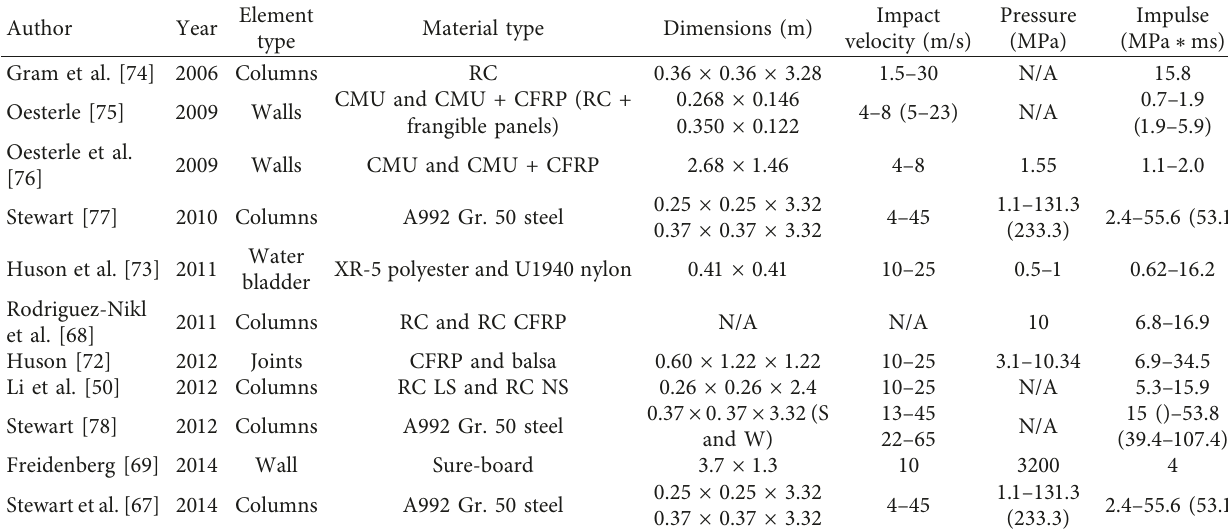
Table 4: Blast simulator tests.